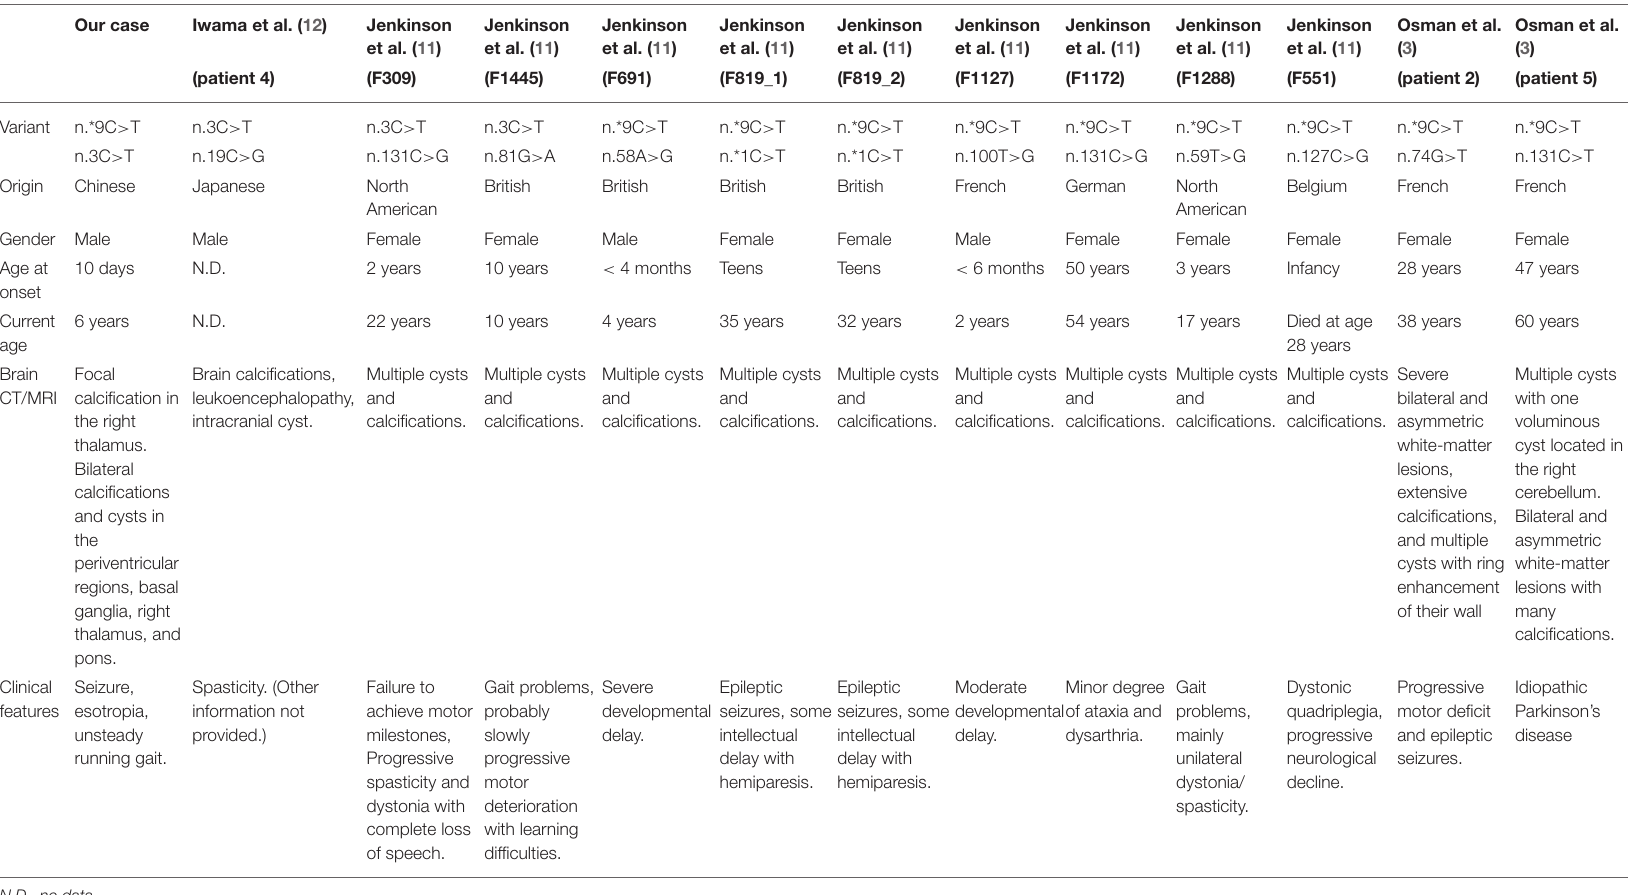
TABLE 2 | Clinical features of our patient and reported patients with the same disease-causing